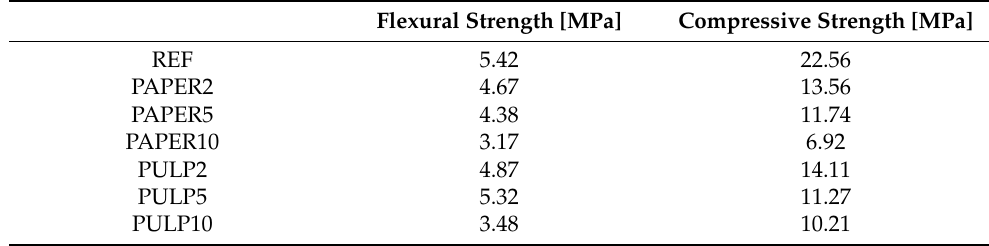
Table 2. Average strengths of tested